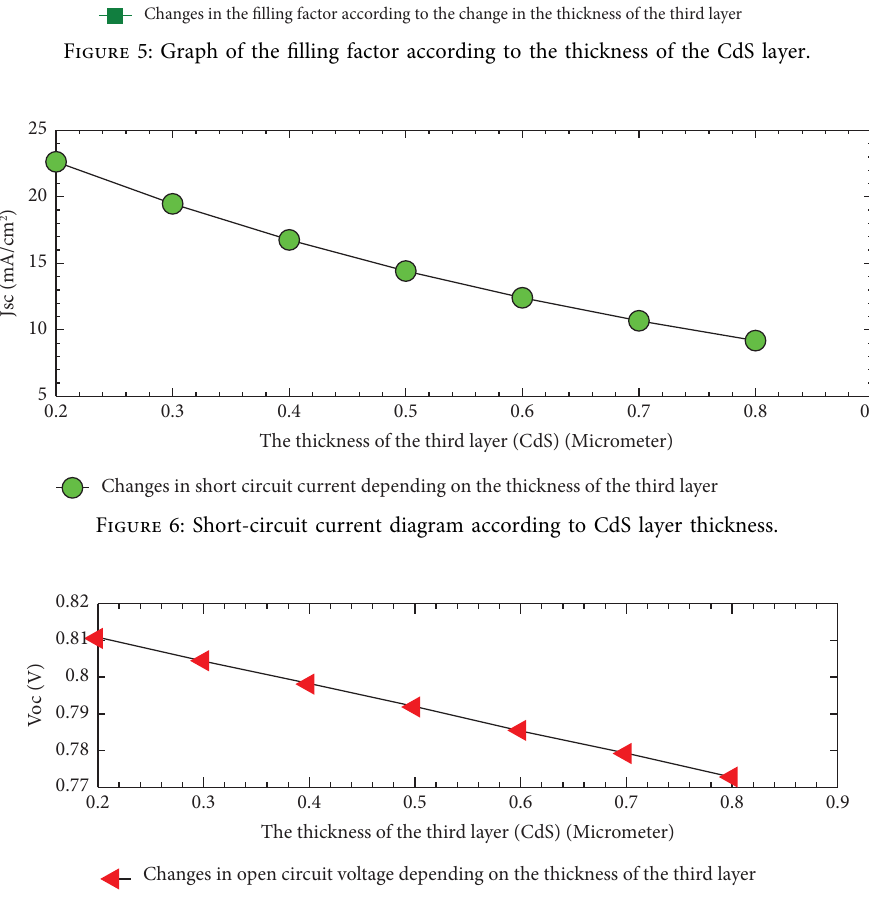
Figure 7: Open-circuit voltage diagram according to the thickness of the CdS layer.